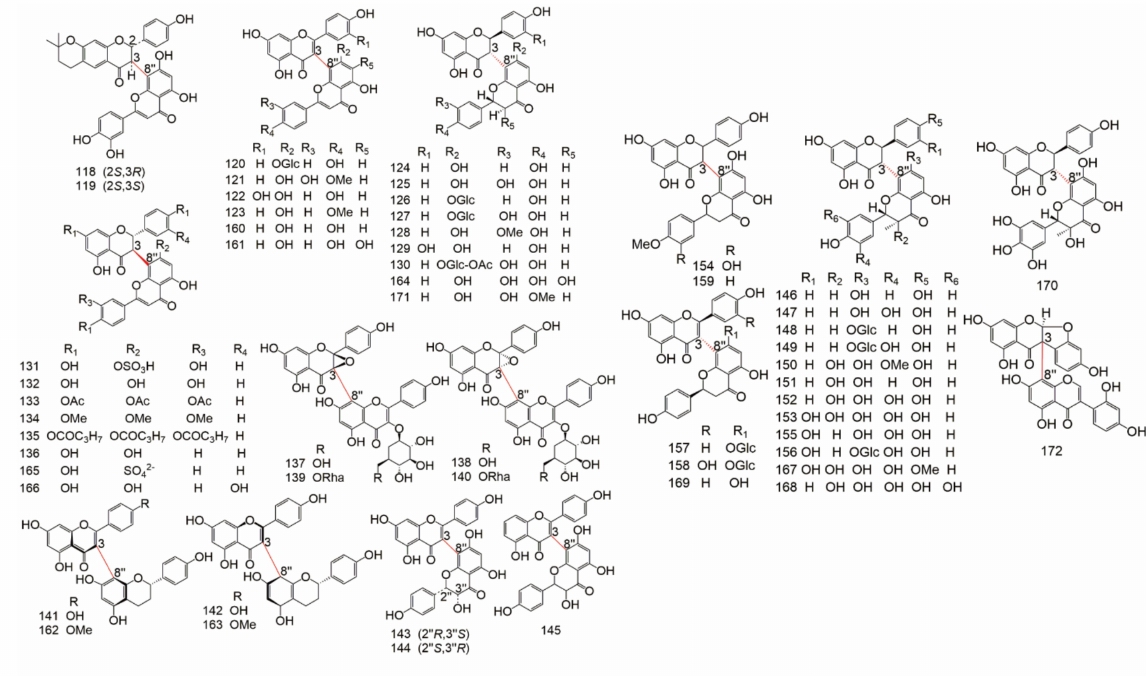
Figure 4. The structure of 3-8 (cid:48)(cid:48) type